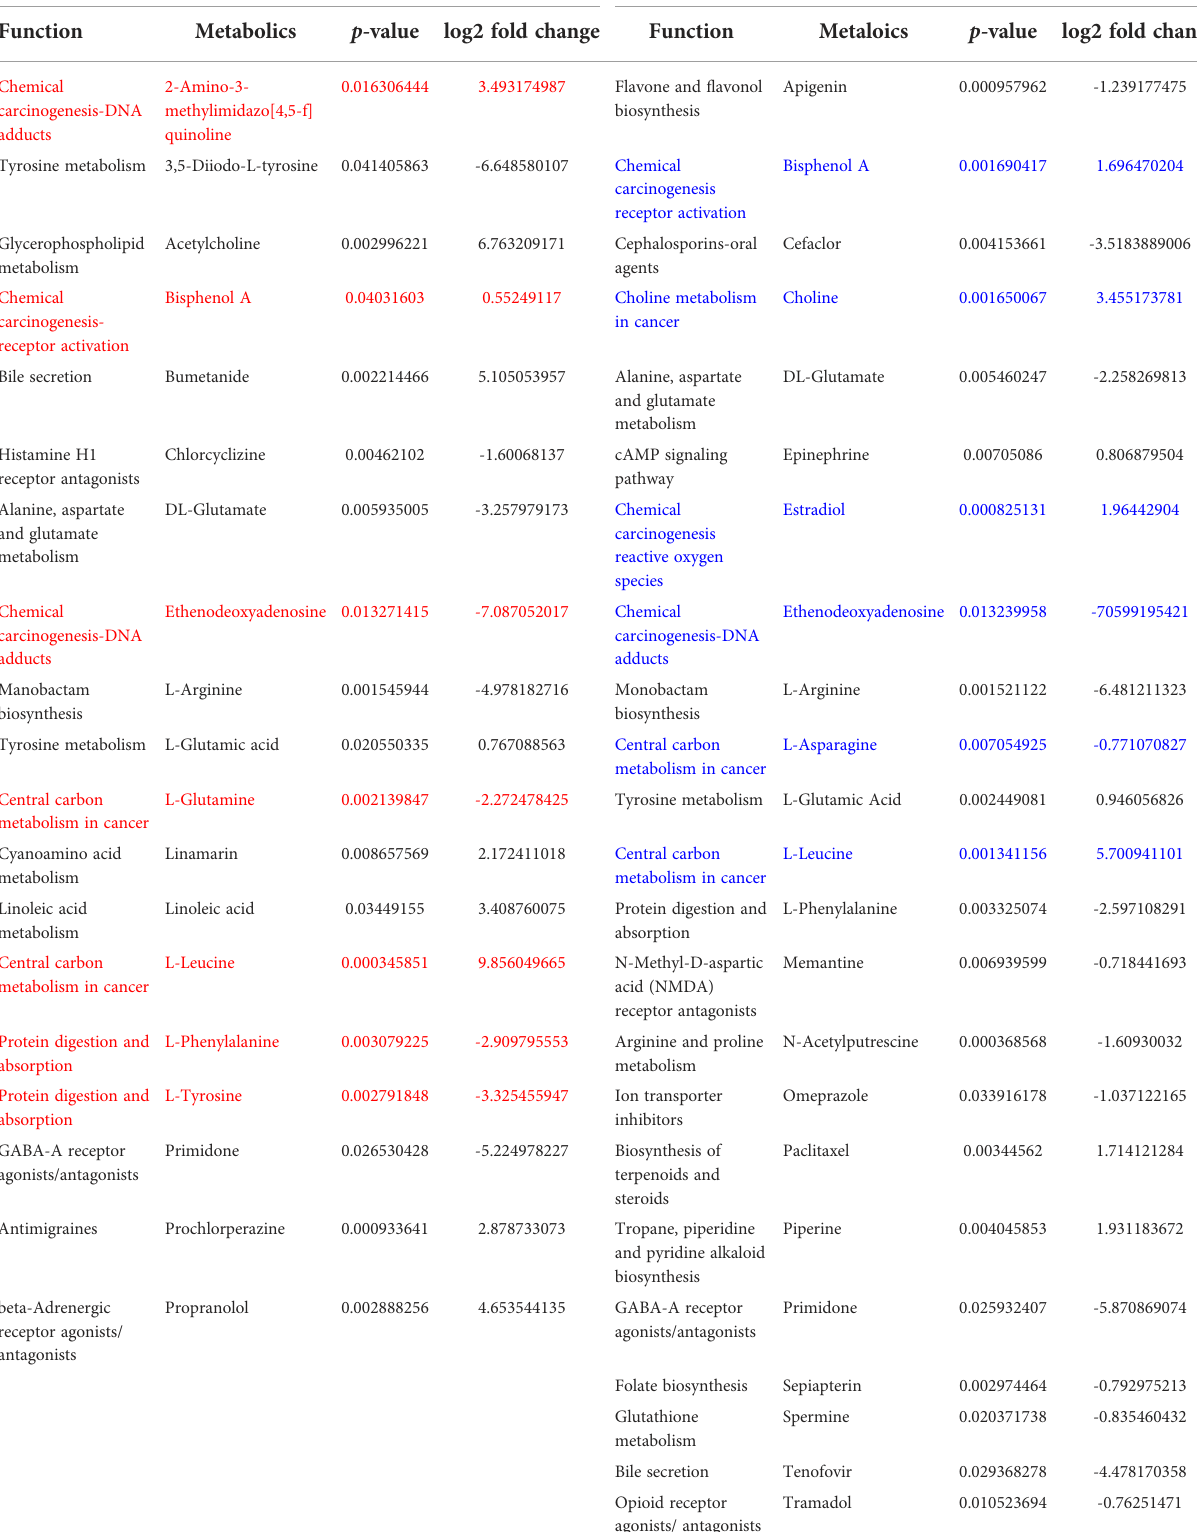
TABLE 1 Enrichment analysis (response function) results for the pH 2 vs. pH 7 and pH 4 vs. pH 7 groups and types of